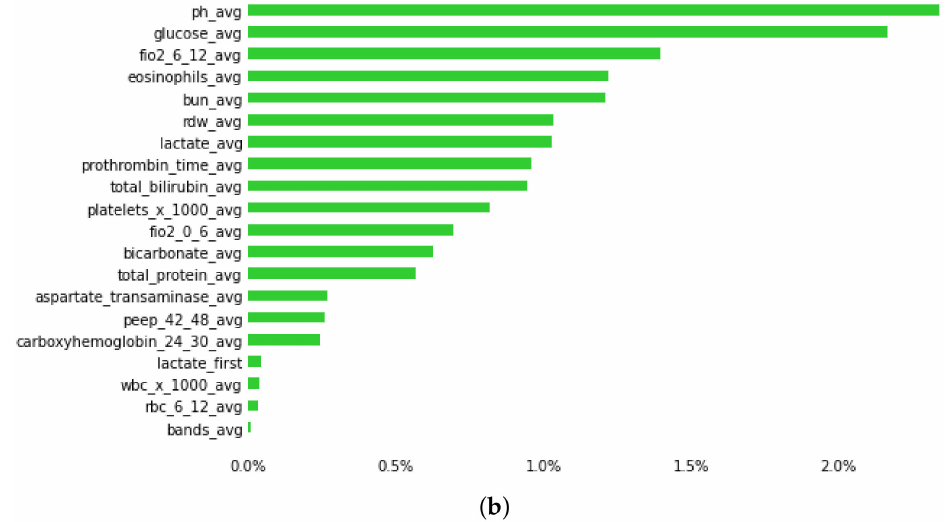
Figure 4. Plot showing predictive features of early mortality in ICU patients with thrombosis, using ( a ) all features and ( b ) labs datasets. Green bars represent the average percentage drop in predictive performance when the feature is removed from the model. (Abbreviations: avg, average; bun, blood urea nitrogen; fiO2: fraction of inspired oxygen; rdw, red cell distribution width; peep, positive end expiratory pressure; wbc, white blood cells; 0–6, 6–12, 24–30, 42–48 is the time in hours after admission).